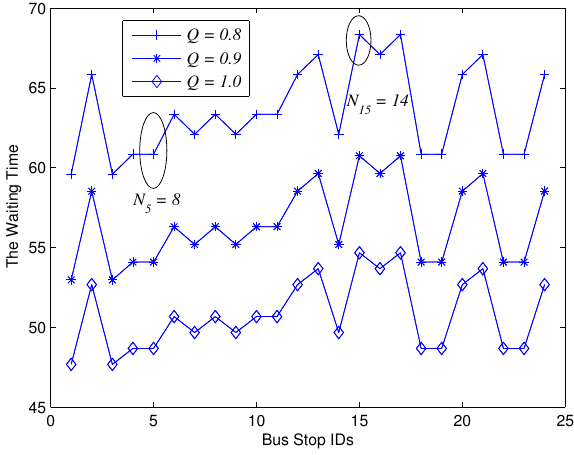
Figure 15. A typical run of the waiting time with bus stop IDs: Q = 0.8 with T avg = 63.6 time unit; Q = 0.9 with T avg = 56.5 time unit; and Q = 1.0 with T avg = 50.8 time unit. Note that N 5 is the bus stop ID 5 with the number of waiting